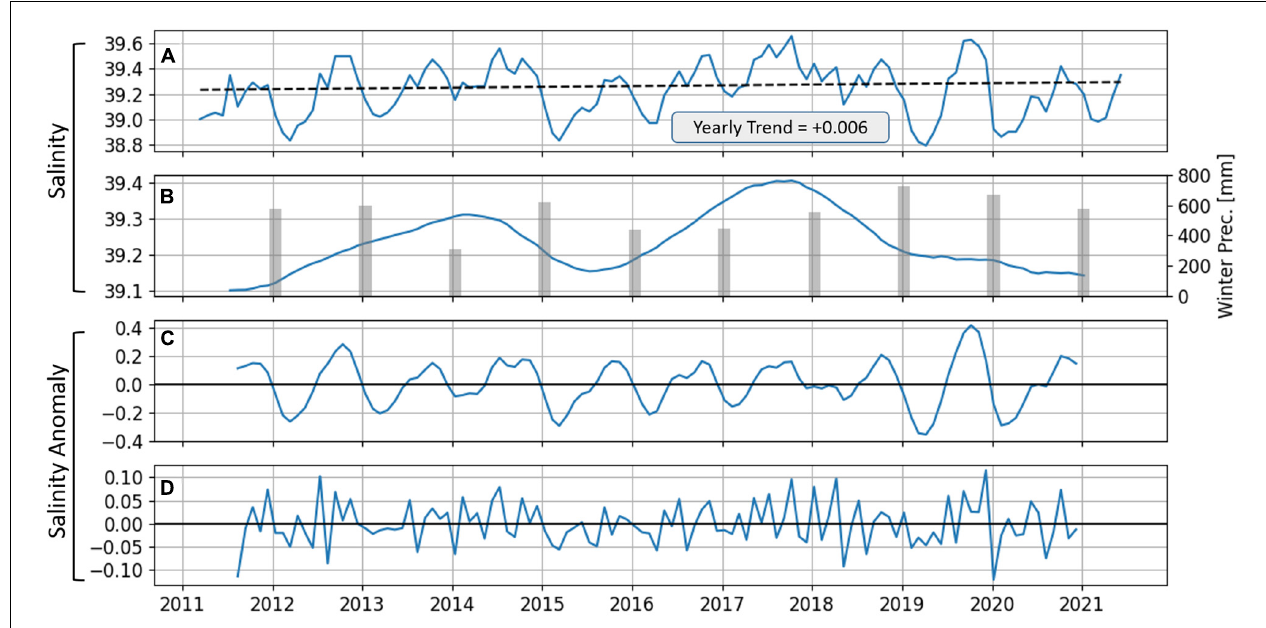
FIGURE 4 | Monthly averaged Hadera CTD salinity values (A) . Calculated trend (B) , seasonal (C) , and irregular (D) terms achieved using the X11 decomposition method. Yearly linear trend accepted with the seasonal Mann-Kendall test of 0.006 ( p = 4.06 × 10 - 7 , z = 5.06) presented in Panel A (dashed black line and text box). Total winter precipitation is superimposed on the trend in Panel B (Gray